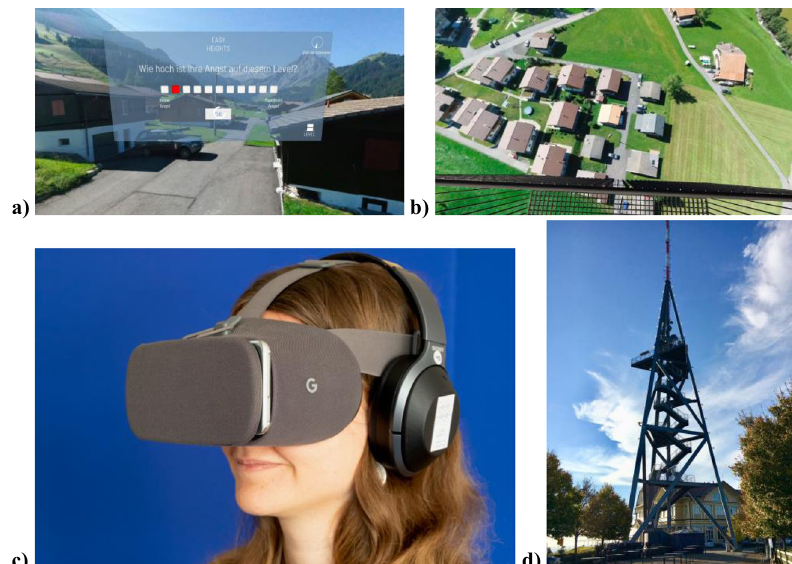
Fig. 3 Virtual Reality exposure app and real-life testing. a In-App content of the Easy Heights mountain scenario on the ground level and b an advanced level from the perspective of the user. c Equipment of the study worn by a team member (written informed consent for reprint is given): an android smartphone with a preinstalled Easy Heights app, noise cancelling headphones and a Google Daydream View version 2 VR headset. d The lookout tower where our Behavioural Avoidance Test (BAT) was